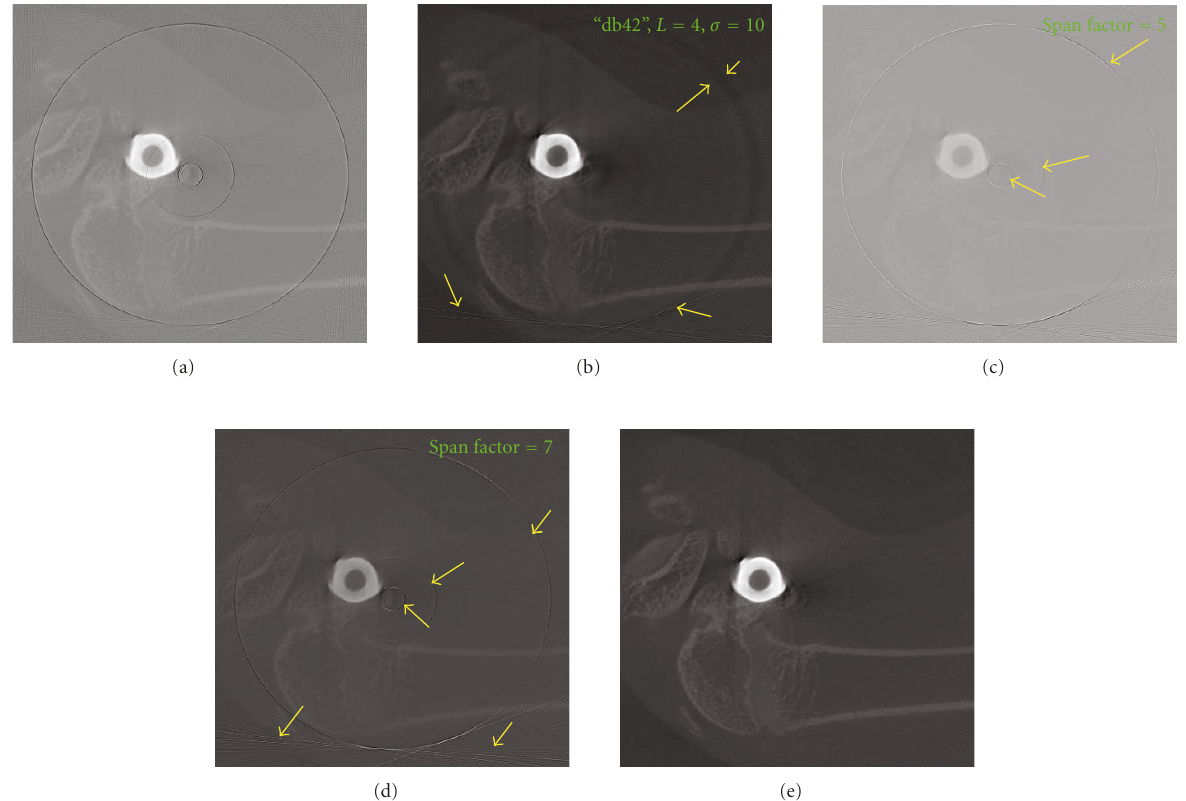
Figure 8: Reconstructed images of Rabbit Bone with an Implant from the corrected sinogram using di ff erent methods. (a): Original image, (b): Wavelet-Fourier method, (c): MA method, (d): Median method, and (e): Proposed